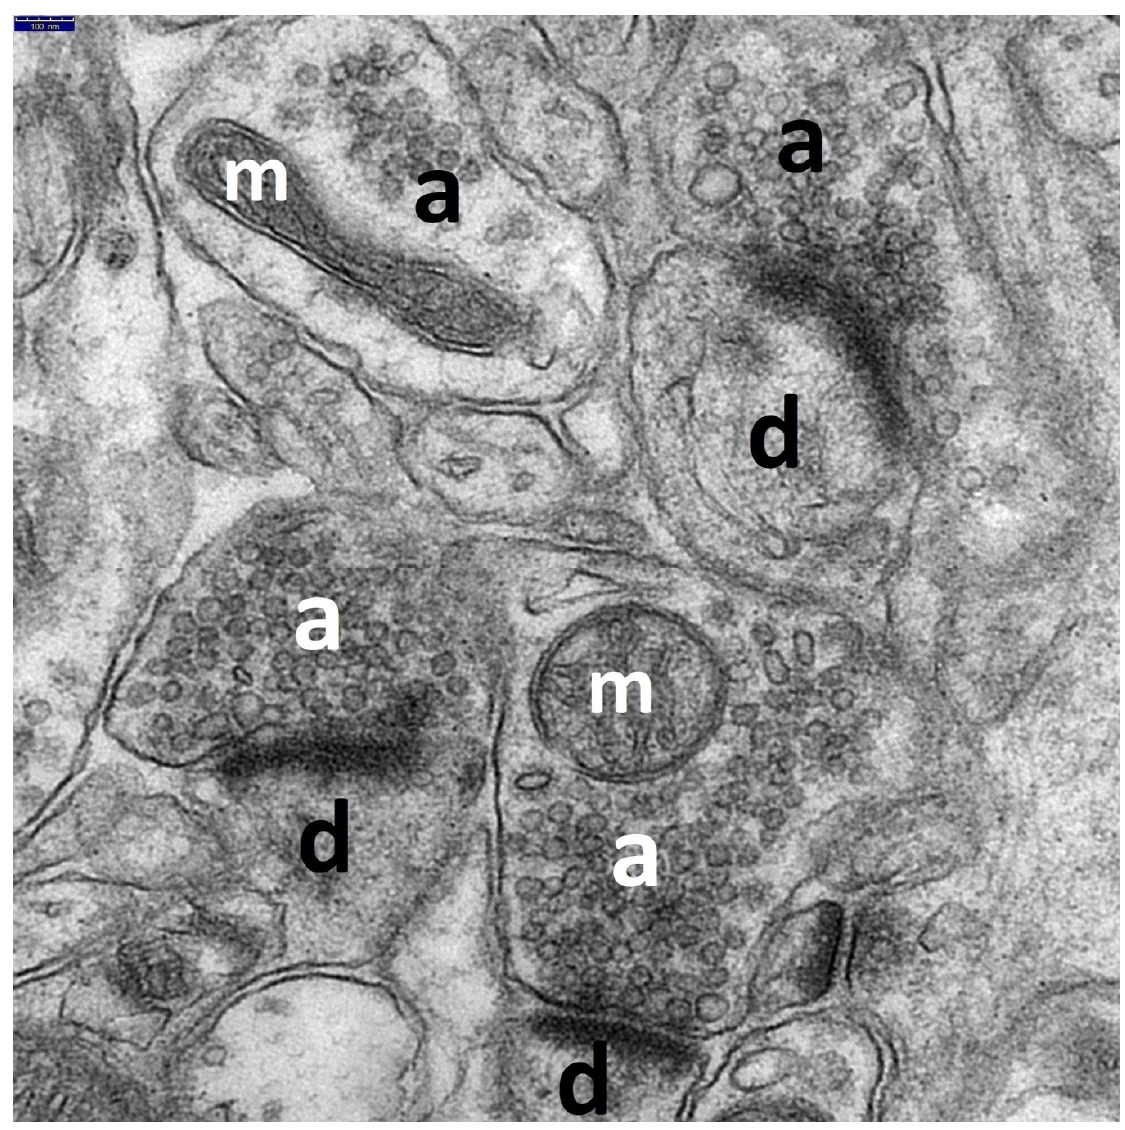
Figure 1. The electronogram demonstrates well-preserved neuropil components of the temporal lobe neocortex in the control group. The majority of the synaptic endings and axodendritic junctions show normal ultrastructures. The presynaptic (a) and postsynaptic (d) parts of the synapses are clearly seen. Most of the axonal-end bulbs are filled with a large number of synaptic vesicles, mainly spherical in shape, evenly distributed within the axoplasm, and containing unchanged mitochondria (m); one axonal ending shows a smaller content of synaptic vesicles. Normal picture of axodenditic junctions; synaptic active zones are distinct and long with well-preserved postsynaptic density thickness. Scale bar: 100